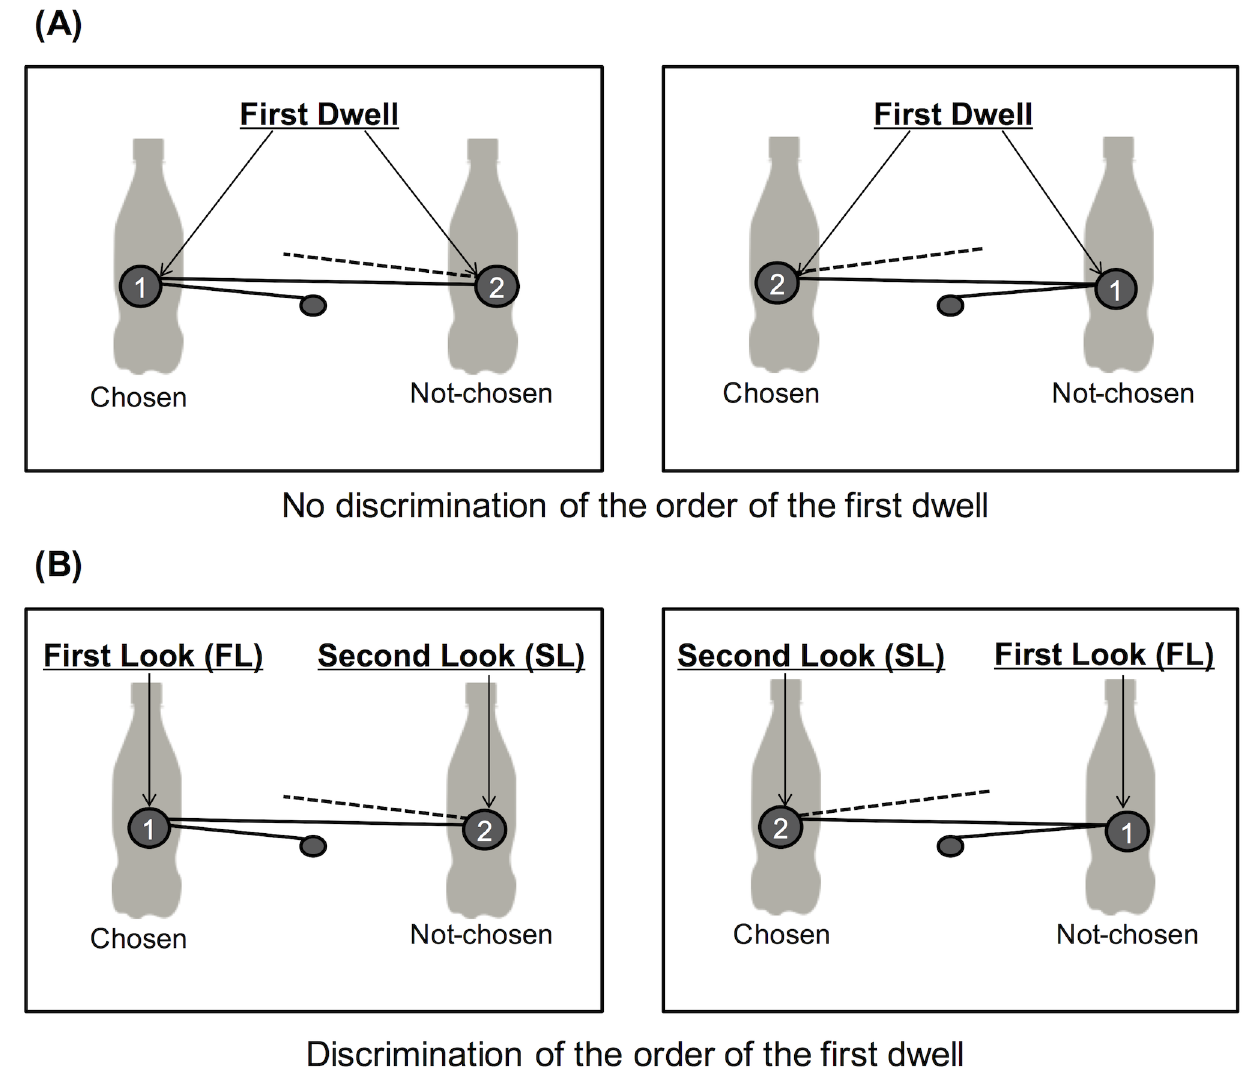
Fig 1. Different approaches to first dwell time of (A) previous studies [11, 12] and (B) the present study, with the 2AFC paradigm. Dots and solid lines represent participants’ eye movement, and the numbers represent the order of dwells.Dashedlines represent eye movementsafter the second look (not arguedin this paper). In the previousstudies, there was no discrimination betweenthe first look (FL) and the second look (SL), becausethe effects of the order of dwells were not considered. In the present study, the FL and SL were clearly discriminated and the relationship betweenthe order of dwells and gaze bias was